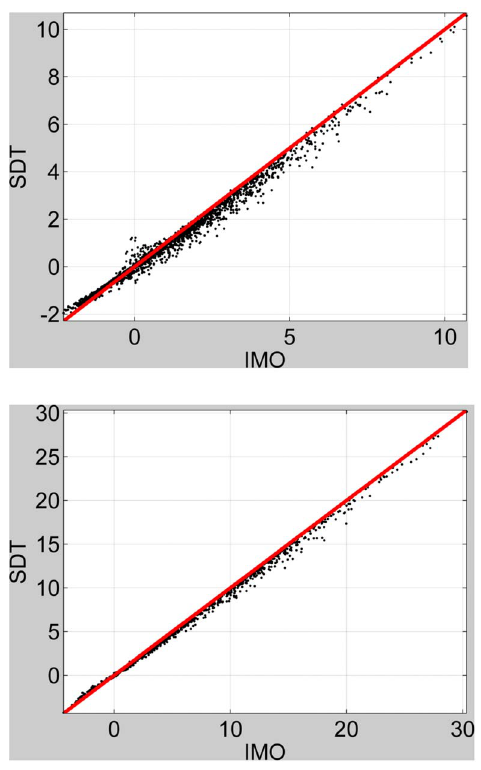
Figure 8. Second-level models. Top Panel: log Bayes factor for SDT versus IMO approaches testing for response in 6 to 12 s time bins. The red line denotes equality. Bottom Panel: log Bayes factor for SDT versus IMO approaches testing for responses that are better explained by a 4 to 6 s model than a 6 to 8 s model.